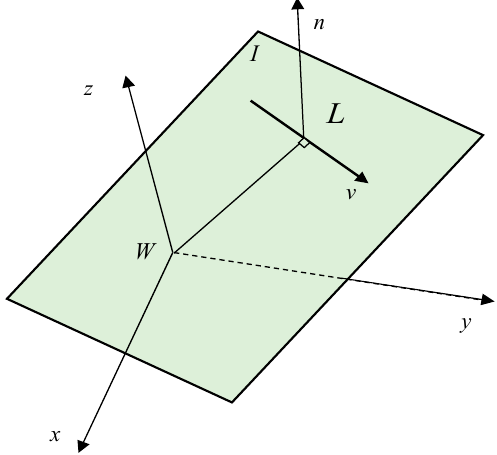
Figure 2. Spatial line and Plücker coordinates.